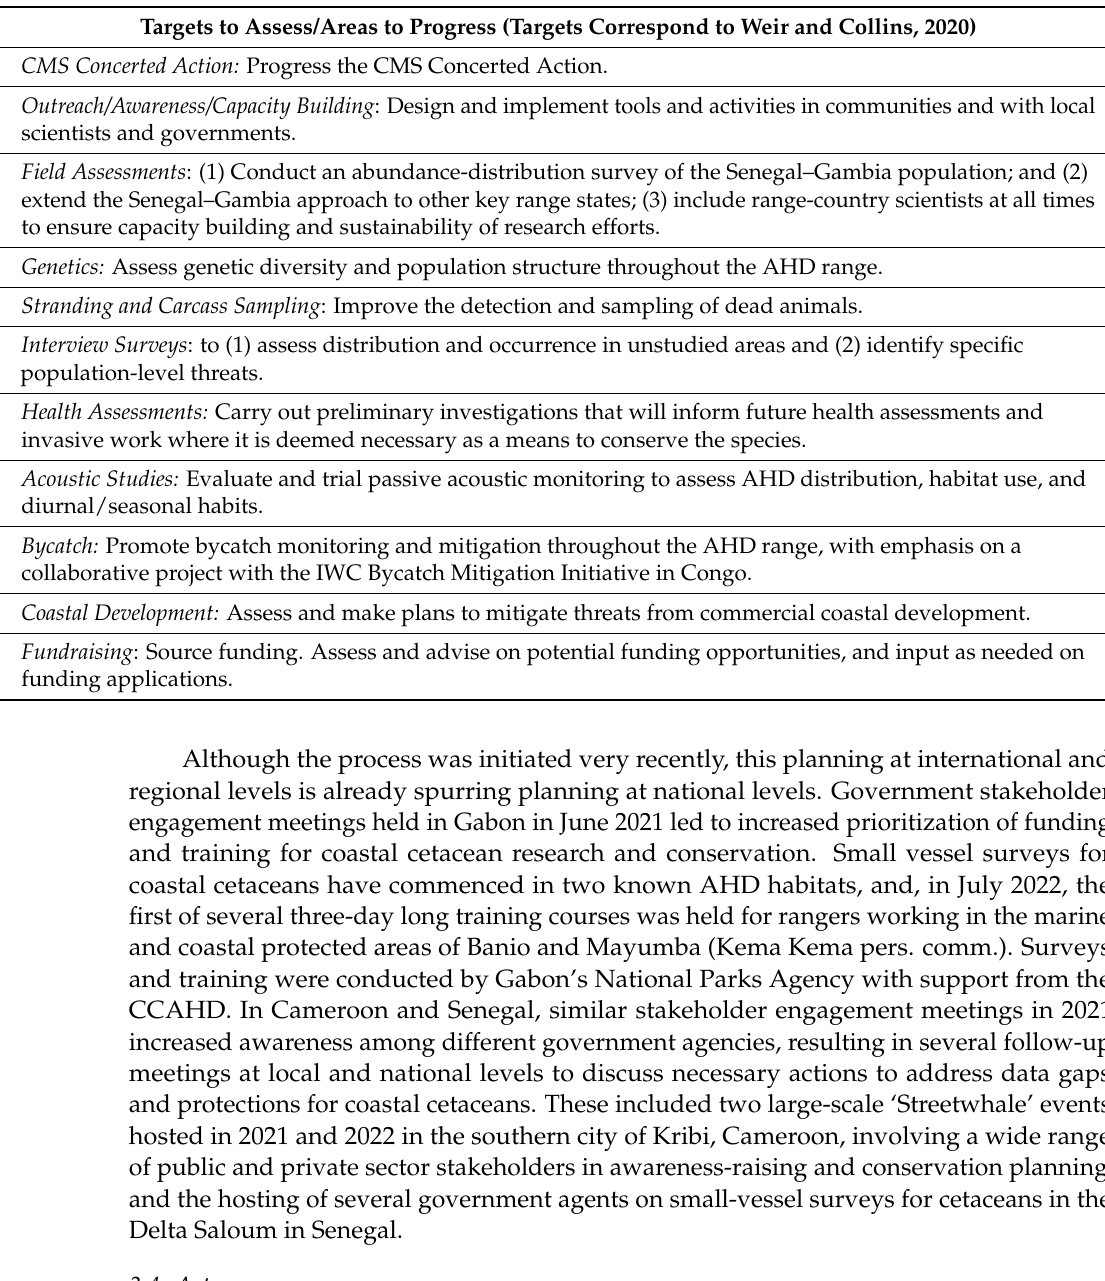
Table 1. Working groups under the Consortium for the Conservation of the Atlantic Humpback Dolphin and their